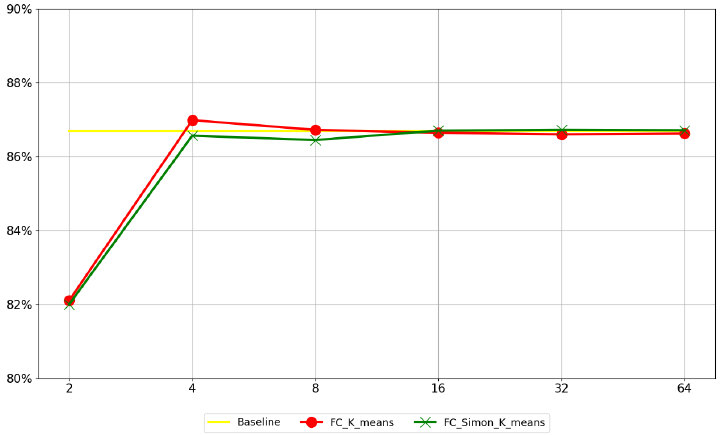
Figure 8. Accuracy of ResNet50 for each fully connected layer with different values of k